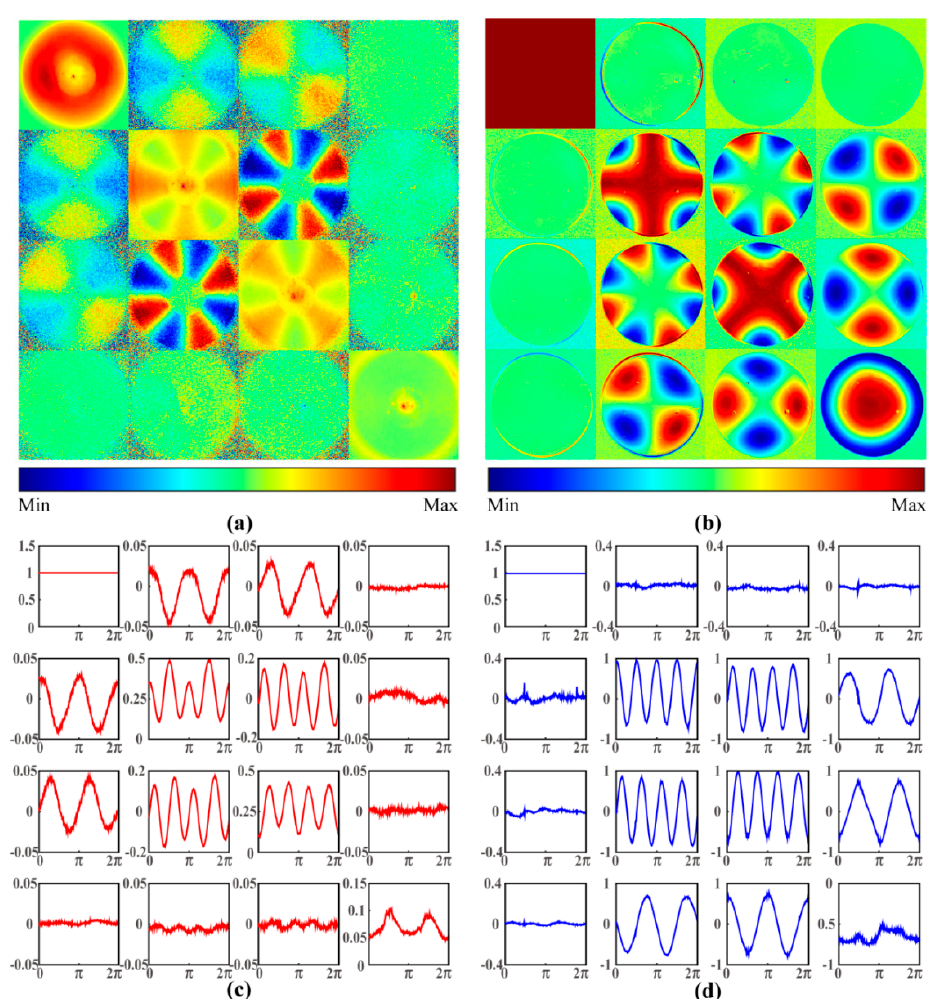
Figure 2. ( a ) A 2D backscattering Mueller matrix image of silk phantom. The color code for m12, m13, m21, and m31 is from − 0.1 to 0.1. The color code for m23 and m32 is from − 0.2 to 0.2. The color code for other elements is from − 1 to 1. ( b ) A 2D transmission Mueller matrix image of birefringent gradient-index (GRIN) lens. The color code for all 16 elements is from − 1 to 1. Azimuthal dependent curves of the Mueller matrix elements for ( c ) the silk phantom and ( d ) the GRIN lens. All the Mueller matrix elements are normalized by m11.